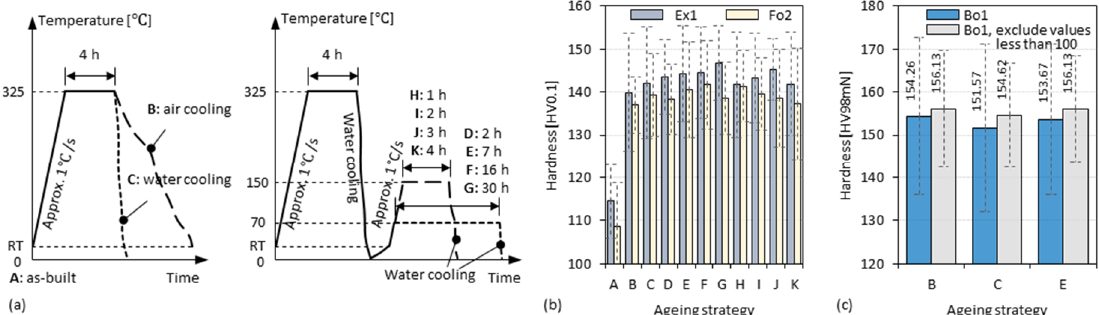
Figure 17. ( a ) Schematic diagram of the single-stage (left) and double-stage (right) ageing strategies; hardness obtained by different ageing strategies in specimen ( b ) Ex1, Fo2, and ( c ) Bo1.